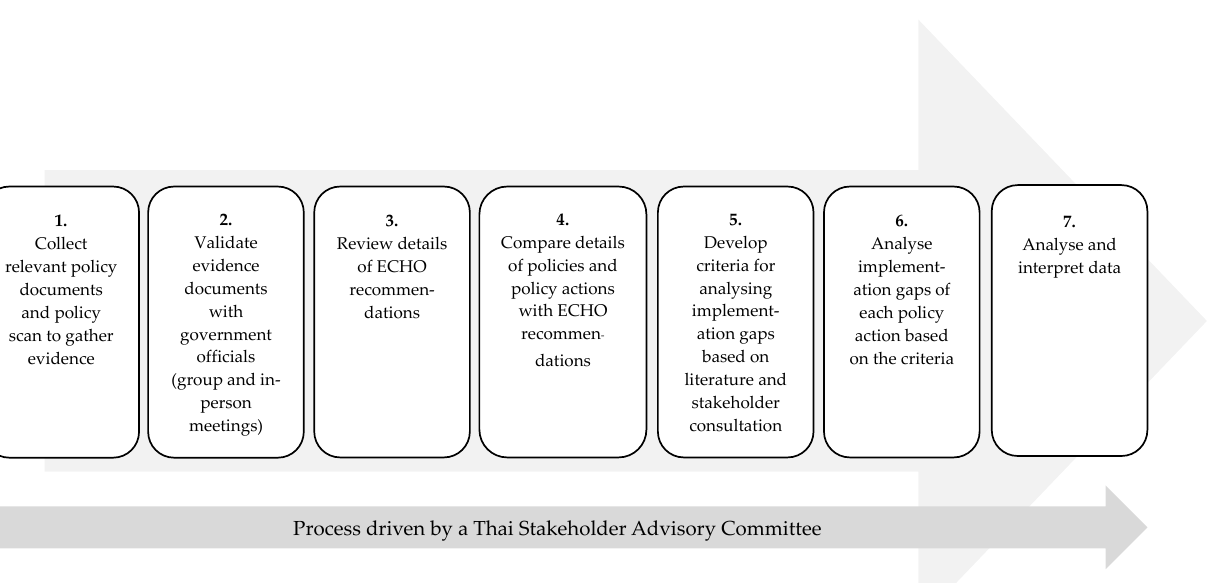
Figure 1. The seven-step process for data collection and analysis.